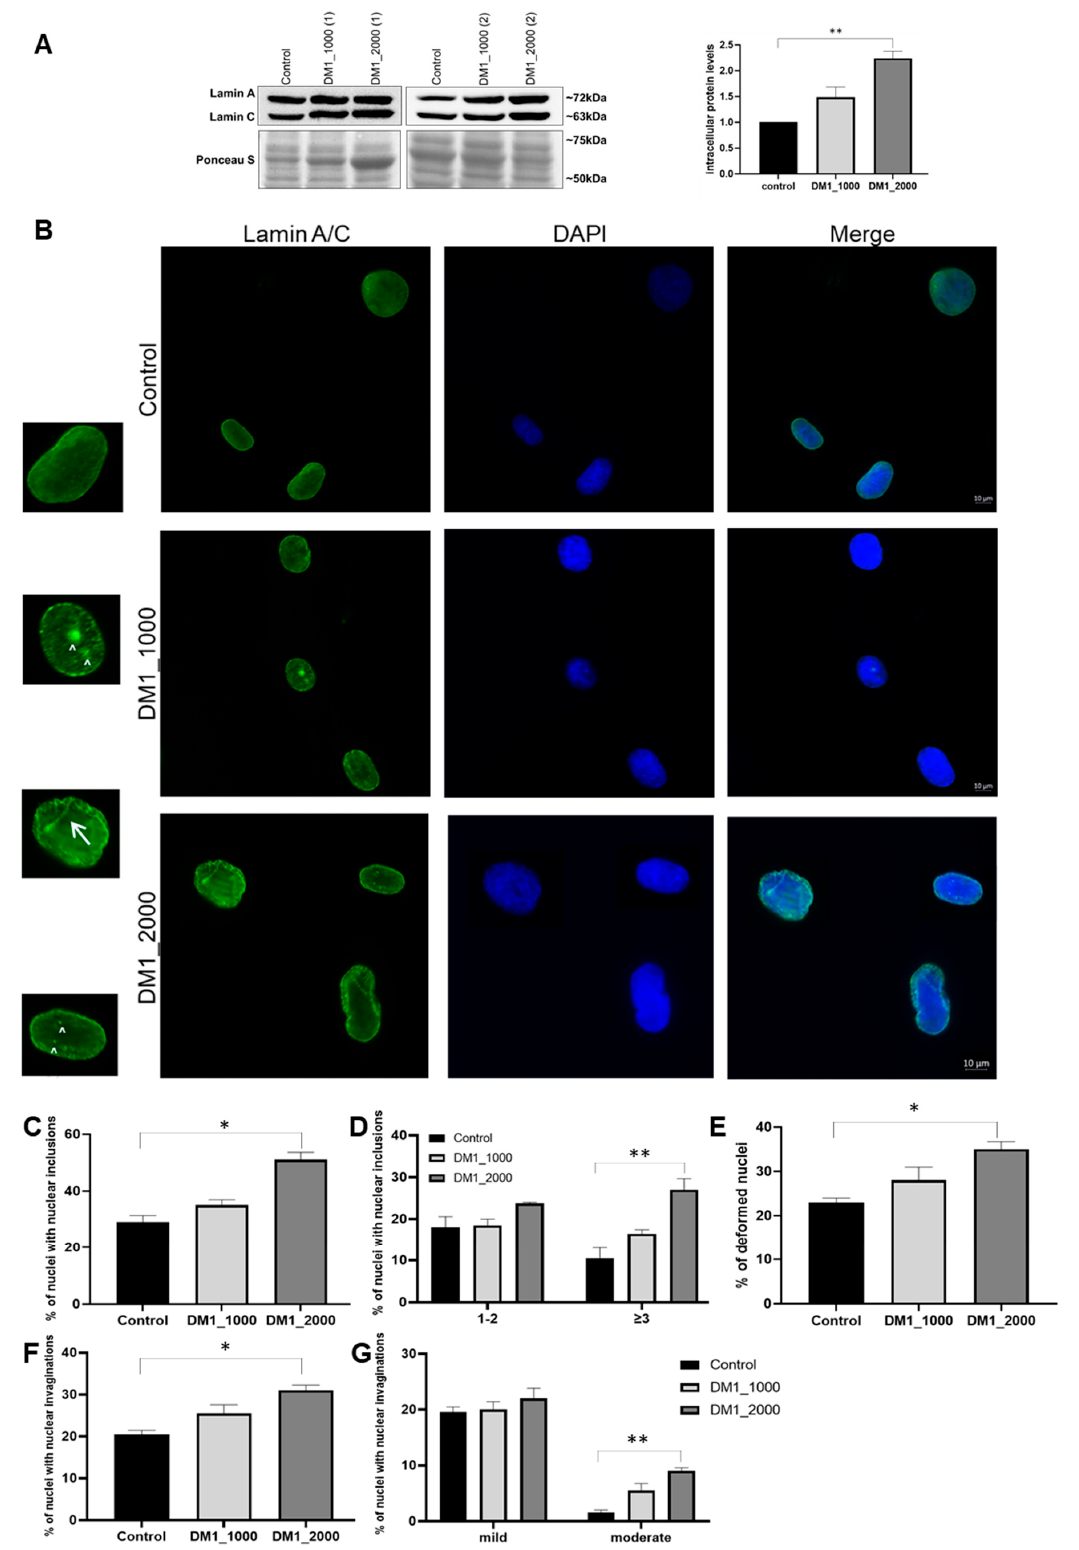
Figure 3. Intracellular protein levels and nuclear localization of lamin A/C in DM1 patient-derived and control fibroblasts. ( A ) Intracellular lamin A/C protein levels in DM1 patient-derived and control fibroblasts were analysed using immunoblotting. The intracellular protein levels in DM1 patient-derived fibroblasts were estimated in relation to protein levels detected in the control condition and are